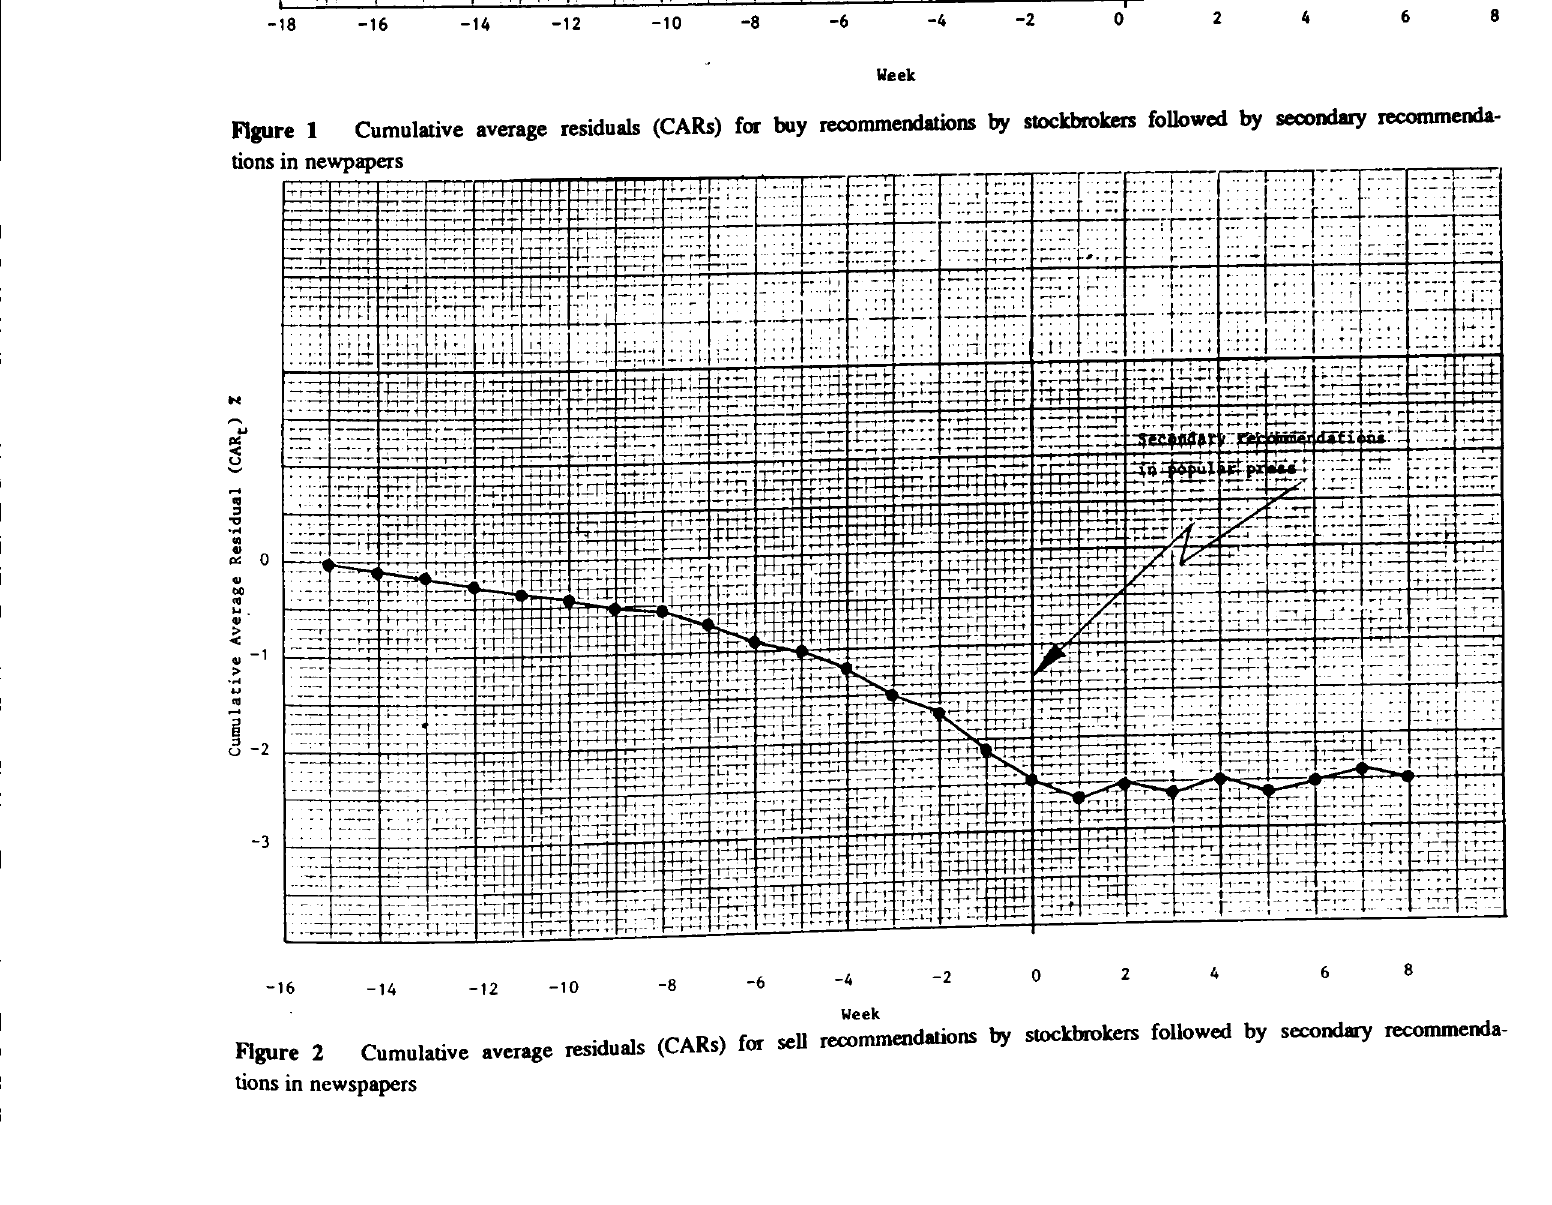
Figure 2 Cumulative average residuals (CARs) for sell recommendations by stockbrokers followed by seconduy recommenda- tions in